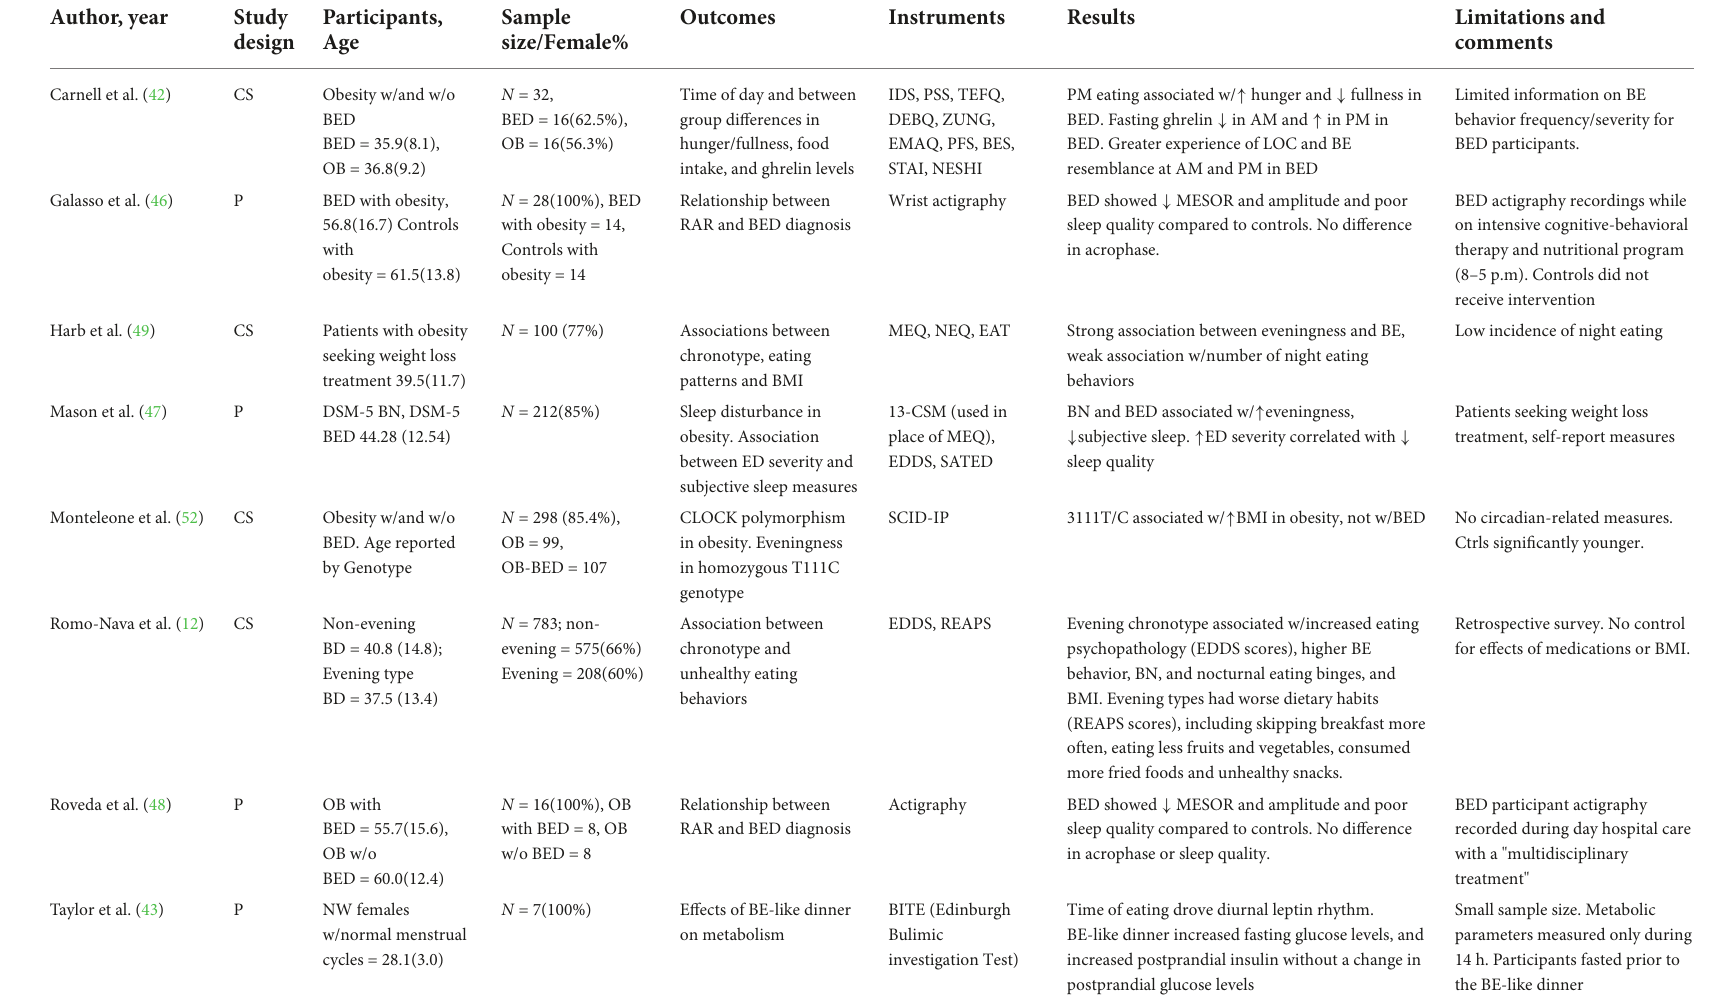
TABLE 2 Assessment of circadian-related measures among individuals with BE